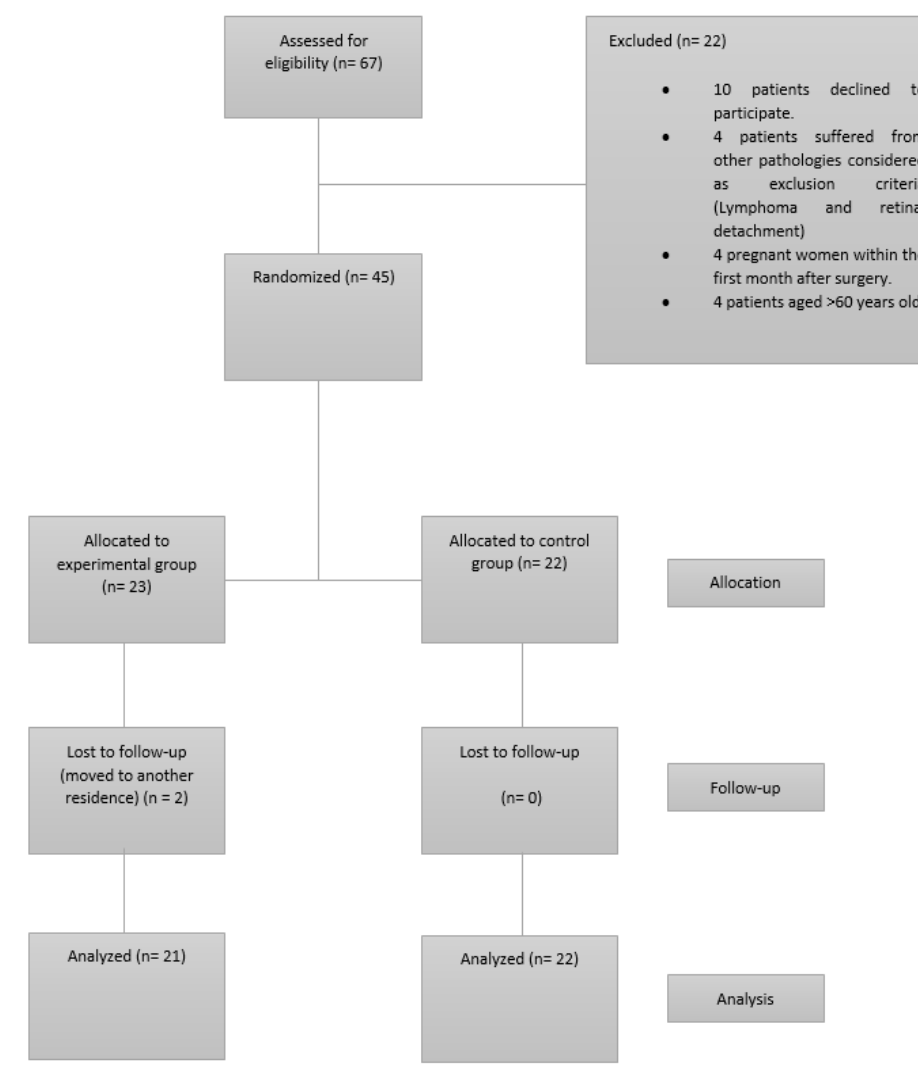
Figure 1. Flow Figure 1. Flow diagram.